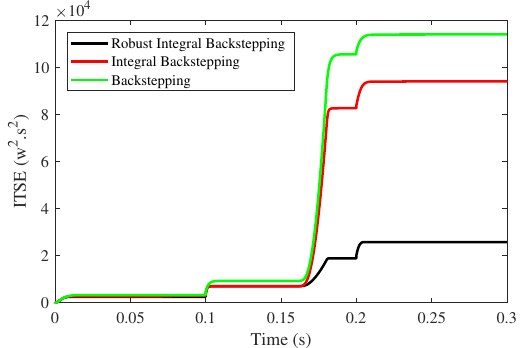
Figure 17. ITSE for multiple faults under varying irradiance and temperature.